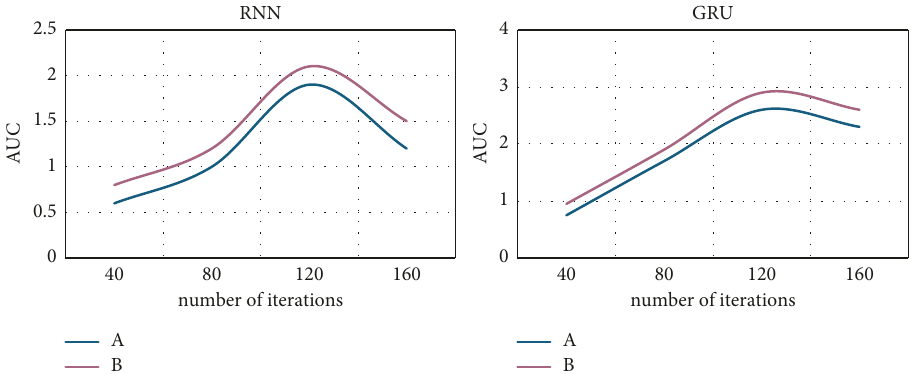
Figure 13: AUC changes in different neural network models.